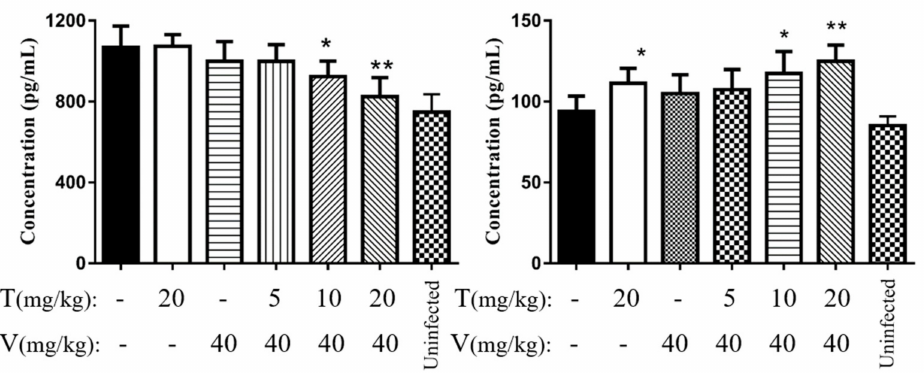
Figure 10. Serum THF- α and IL-6 levels in model mice after treatment. ( A ) THF- α ; ( B ) IL-6. * p < 0.05, ** p < 0.01 versus the PBS (control) group. T, thymol; v, vancomycin